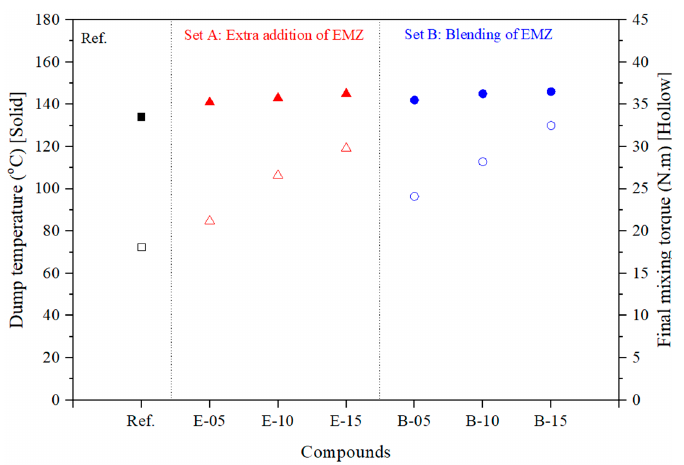
Figure 2. Dump temperatures and final mixing torques of the silica - filled NR compounds as a function of EMZ content added via either extra addition (Set A) or blending (Set B) .